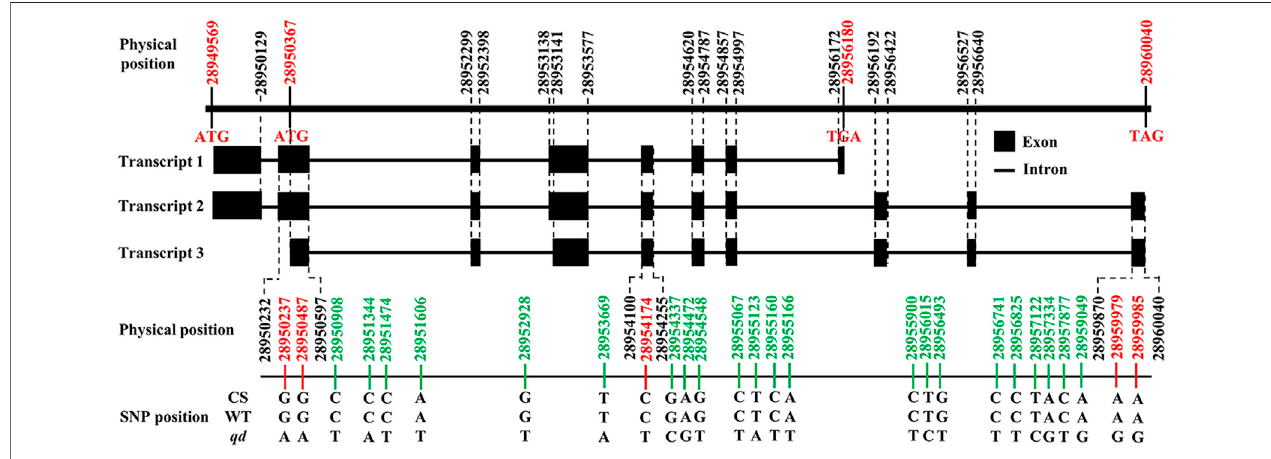
FIGURE 8 | Gene structure of